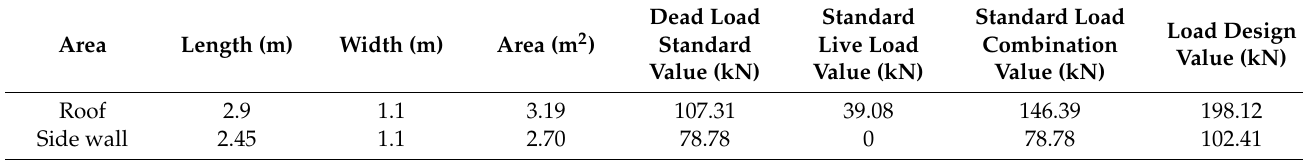
Table 1. Load combination of the utility